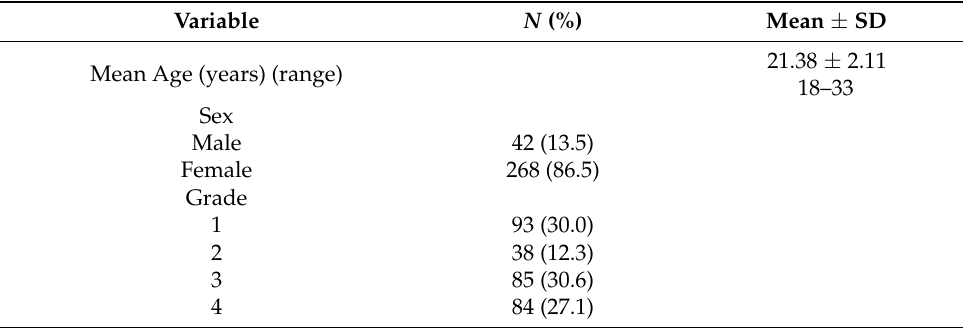
Table 1. Descriptive Statistics ( N =